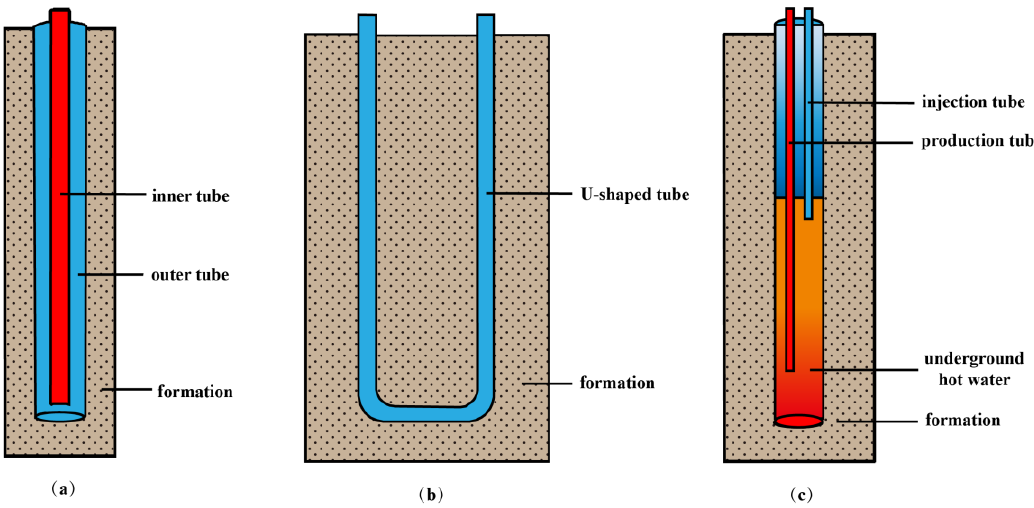
Figure 1. Schematic diagram of medium – deep buried pipe system. ( a ) Single-well system. ( b ) U-shaped well system. ( c ) Doublet-well system.